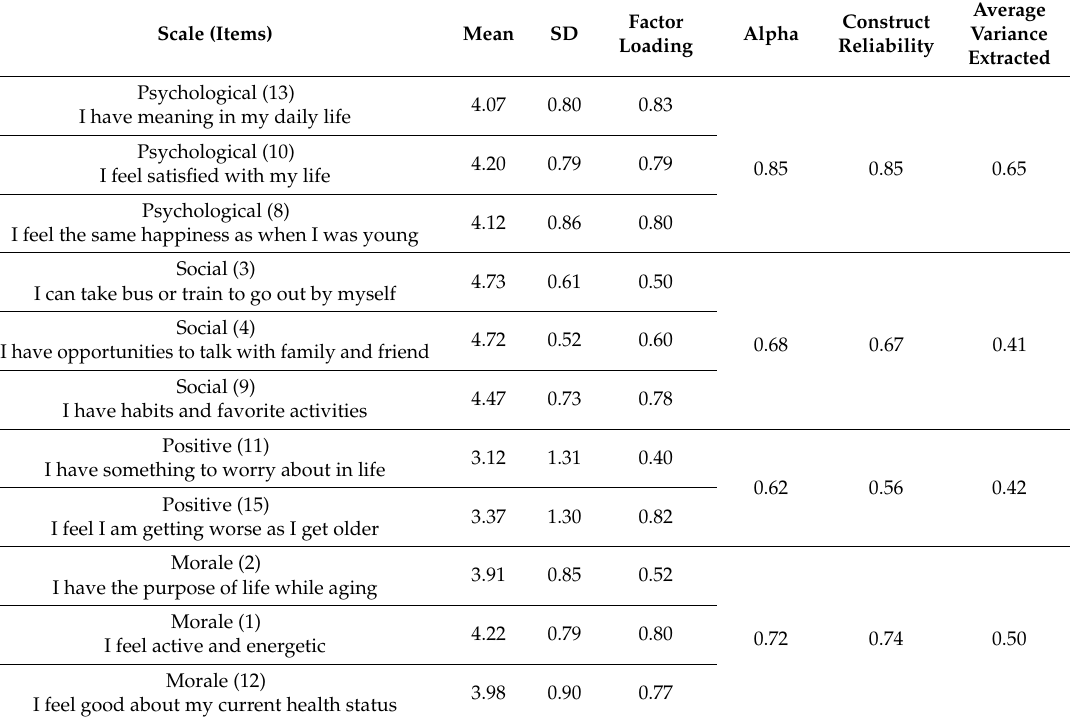
Table A2. The reliability and validity of positive active aging